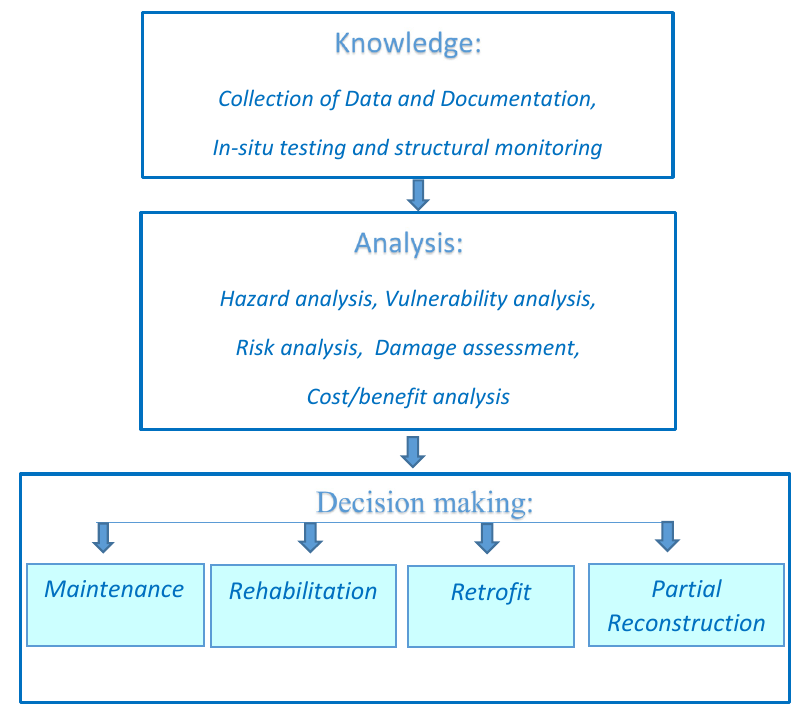
Figure 1. Design process on a historical building.